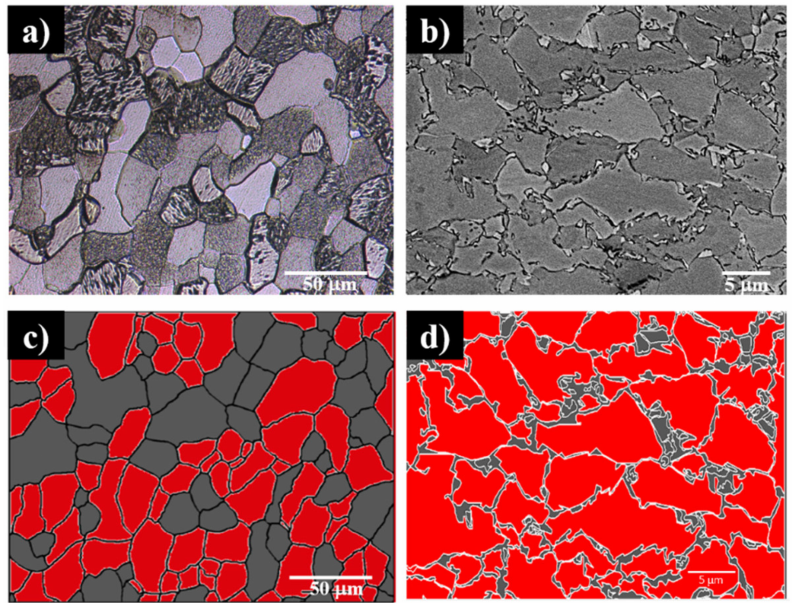
Figure 5. Grain size determination ( a , b ) traces of different phases of LC and DP steel with AutoCAD software; ( c ) perlite count of LC steel and ( d ) ferrite count of DP